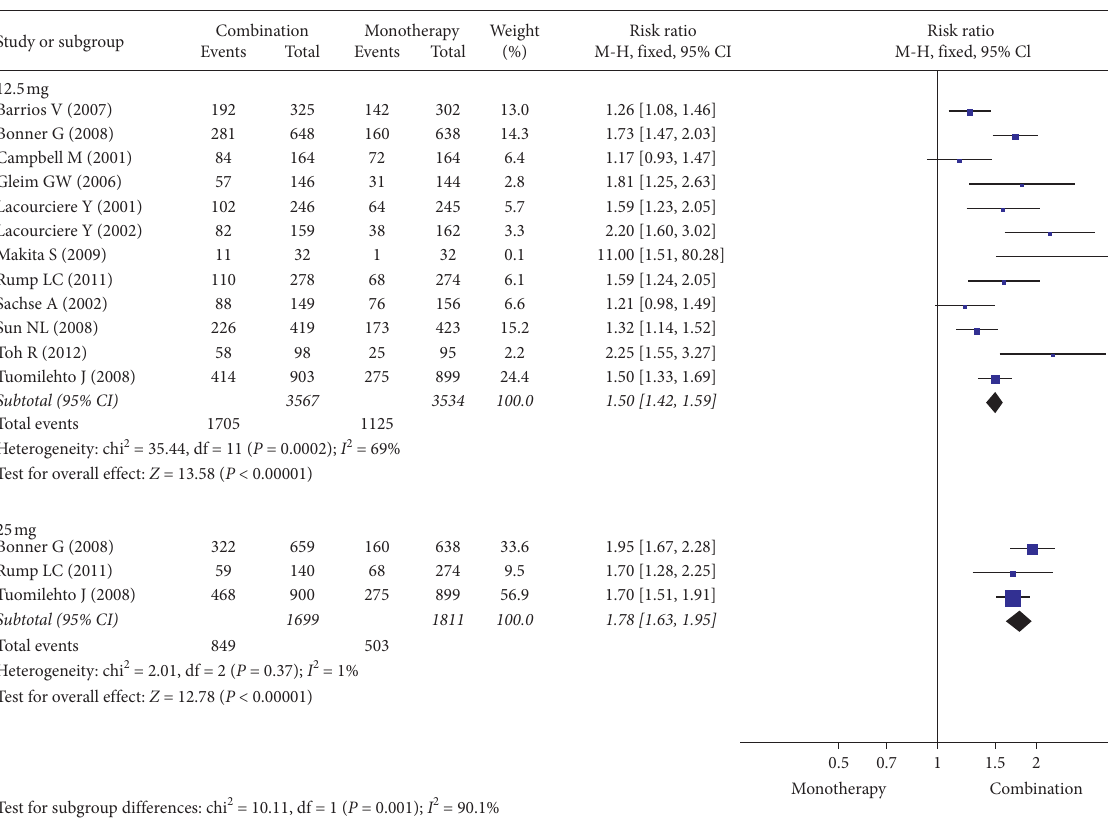
Figure 4: Forest plot for response rate.